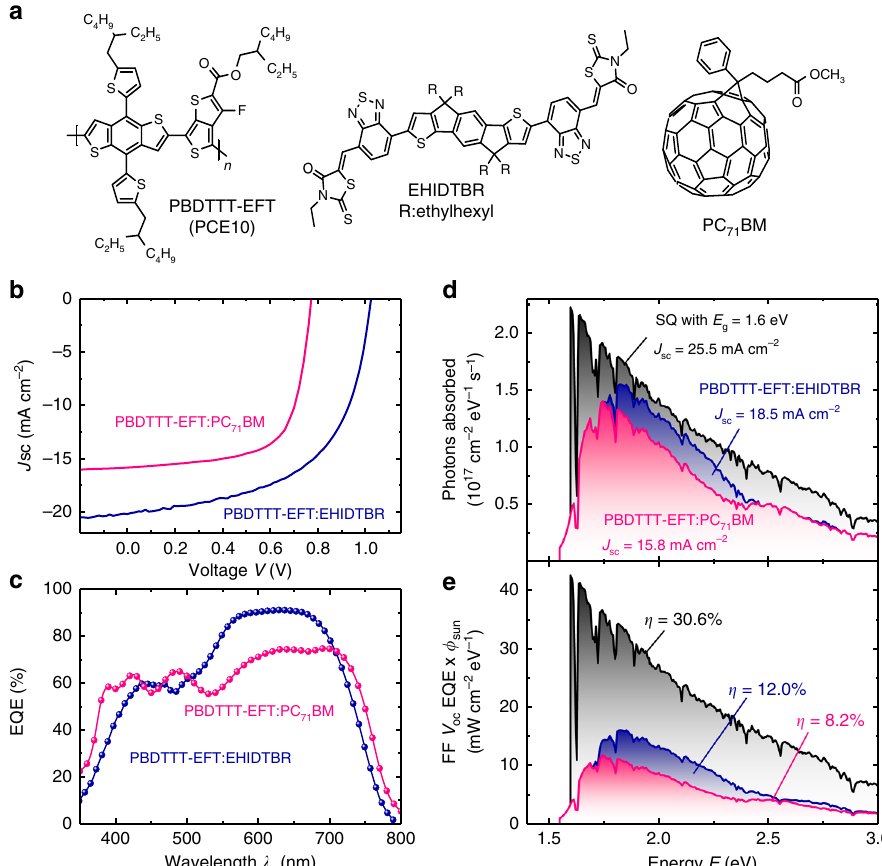
Fig. 1 Chemical structures and photovoltaic characteristics of PBDTTT-EFT devices. a Chemical structures of PBDTTT-EFT, EHIDTBR, and PC 71 BM. b Current – voltage characteristics of PBDTTT-EFT:EHIDTBR and PBDTTT-EFT:PC 71 BM devices under 100 mW cm − 2 illumination. c Internal and external quantum ef fi ciency spectra of the corresponding devices. d External quantum ef fi ciency multiplied with the solar spectrum for the data from c and for a step-function-like quantum ef fi ciency (Shockley – Queisser limit) for a bandgap of 1.6 eV. e Product of solar spectrum, quantum ef fi ciency, fi ll factor, and open-circuit voltage for the three cases from d . The area under the curves in e corresponds to a power density and is directly proportional to the ef fi ciency of the